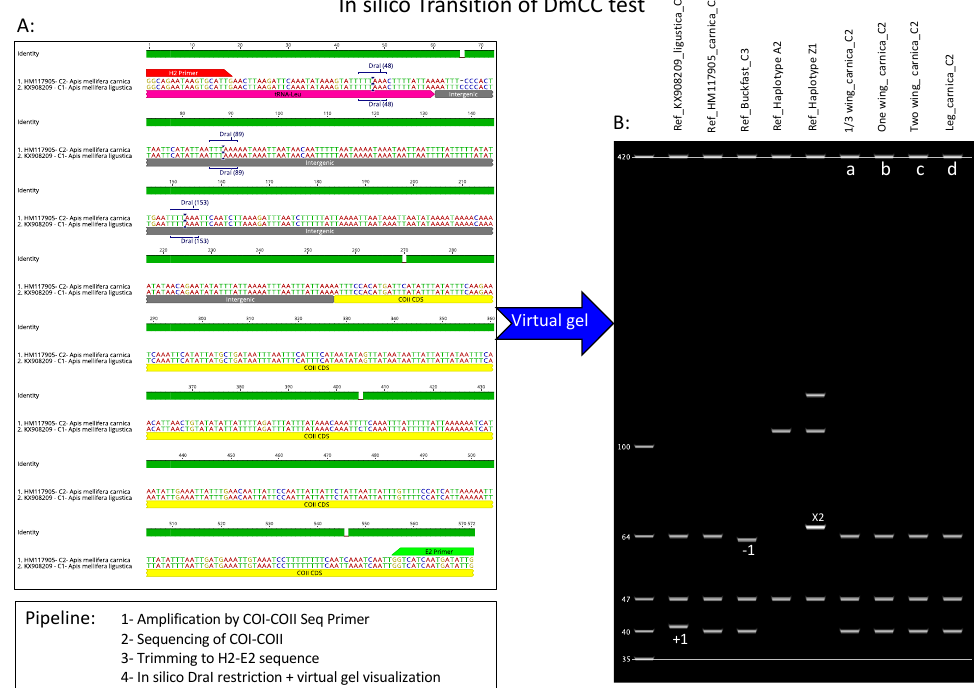
Figure 5. In silico procedures allowing the haplotype identification on a virtual gel. ( A ): trimmed sequence of the COI-COII intergenic at both H2–E2 ends and relevant DraI sites related to the DmCC test. ( B ): in silico DraI restriction and visualization of the fragment on a virtual gel. Reference haplotypes from the African lineage A (A2 and Z1) were added, as well as references of the North Mediterranean lineage C (C1,